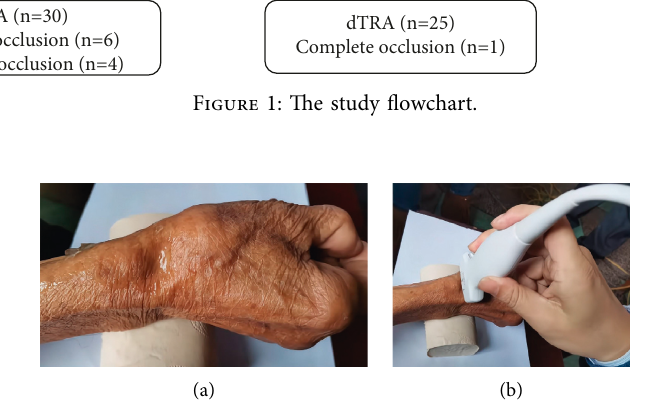
Figure 2: (a) Anatomic snuffbox area in one patient with low body mass index. (b) Ultrasound follow-up operation.